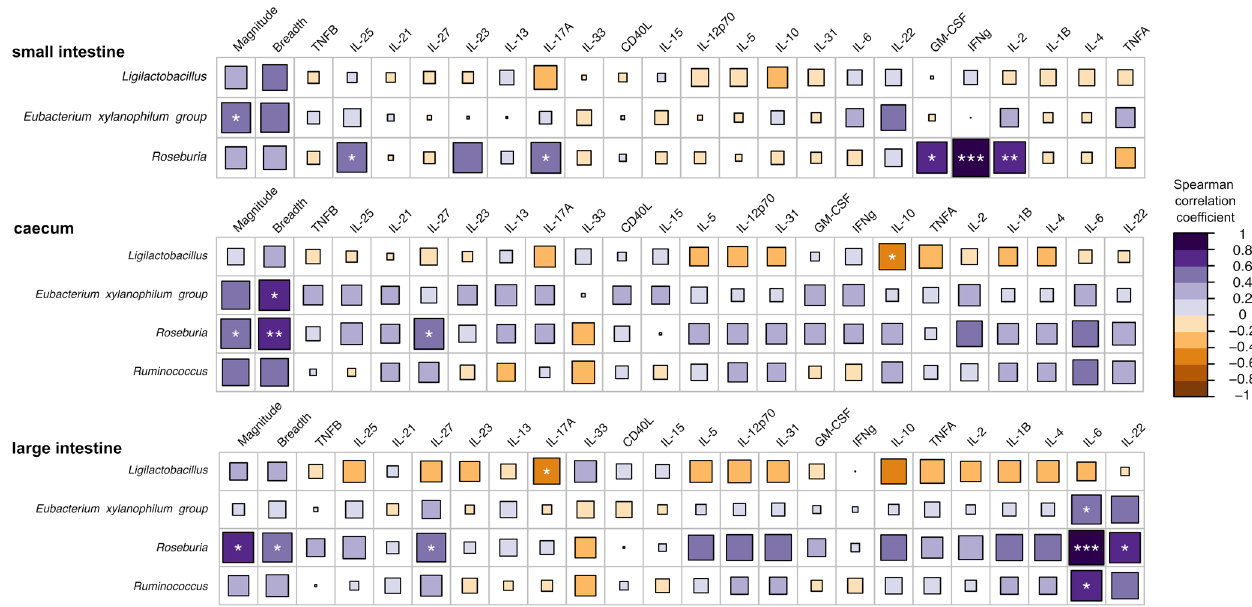
Fig. 4 Correlation analysis between discriminant bacteria, serum cytokines and immunological responses at the last time point of the study. Spearman rank correlations between bacterial genera (only bacteria longitudinally enriched in HTI-immunized mice were evaluated), HTI immunogenicity (magnitude and breadth of the response) and serum cytokine levels. Associations are assessed for each gut section (small intestine, caecum and large intestine). Cytokines for each gut section are ordered based on unsupervised hierarchical clustering. Color and size of the square represent the magnitude of the correlation. Signi fi cance is indicated by white asterisks (* p < 0.05; ** p < 0.01; *** p < 0.001 after Benjamini – Hochberg adjustment for multiple